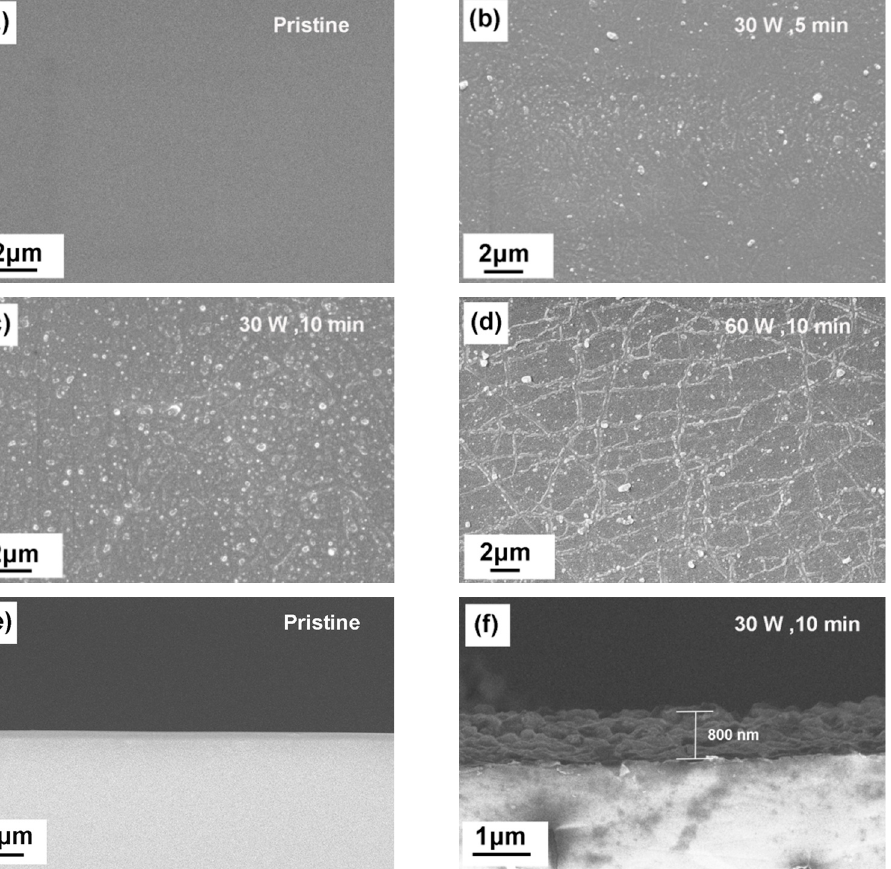
Figure 3. SEM images of the surface of the pristine PDMS ( a ) and the dopamine-modified PDMS assisted by CO 2 plasma treatment ( b – d ). ( b ) C 1 -P, ( c ) C 2 -P, and ( d ) C 3 -P. ( e , f ) are cross-sectional views of pristine and dopamine-modified PDMS (C 2 -P), respectively.